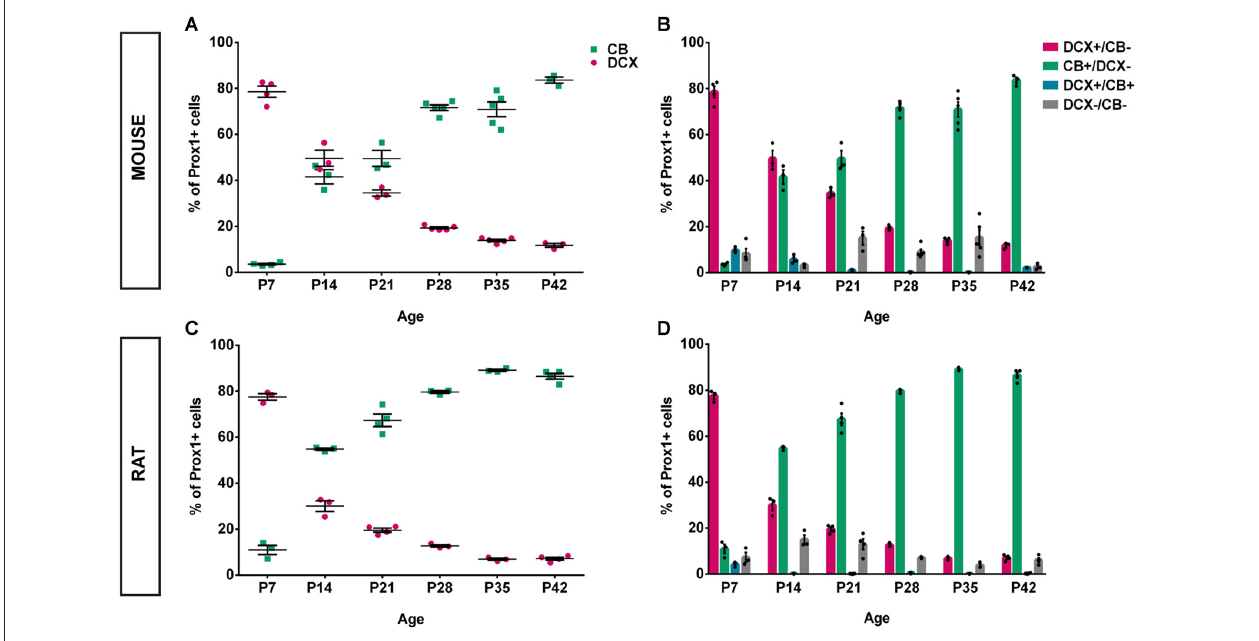
FIGURE 3 | Quantification of CB and DCX expression in the postnatal mouse and rat DG over time. (A) In the mouse, at P7, nearly 80% of all Prox1-positive GCs expressed DCX while less than 4% were CB-positive. However, at P14, the number of DCX-positive GCs dropped to 50%, while 42% expressed CB. This represents the most drastic change during all time points that were examined. DCX expression continued to gradually decrease while the proportion of CB-expressing cells continued to increase until P42. (B) The relative distribution of DCX- and CB-expressing GCs shows a gradual shift toward maturity over time, particularly between P7 and P14. The number of triple-labeled cells that expressed Prox1 as well as DCX and CB constituted 9.62% at P7, less than 6% at P14 and P21, and between 0.11% and 2% from P28 to P42. In addition, Prox1-positive cells expressing neither maturity marker were noted. n P7 = 4; n P14 = 3; n P21 = 3; n P28 = 5; n P35 = 5; n P42 = 3. n = number of animals. (C) Similarly to the mouse DG, nearly 80% of all Prox1-positive GCs in the rat expressed DCX at P7 while 11% were CB-positive. At P14, the rat DG contained 30% DCX-positive and approximately 55% of CB-expressing GCs. Thus, the shift toward maturity between P7 and P14 was greater compared with the mouse. From then on, the proportion of DCX-positive GCs continued to decrease while the percentage of CB-expressing cells increased gradually until P28 after which there was only little change until P42. (D) The distributions of DCX and CB in GCs over time show a striking shift from immature to mature GCs between P7 and P14. The proportion of GCs expressing both DCX and CB was extremely low at all time points, with 4% at P7 and less than 0.6% at all other time points. The fraction of GCs not expressing either maturation marker constituted between 7%–15% at P7–21 and 4%–7% at P28–42. n P7 = 3; n P14 = 3; n P21 = 4; n P28 = 3; n P35 = 3; n P42 = 4. n = number of